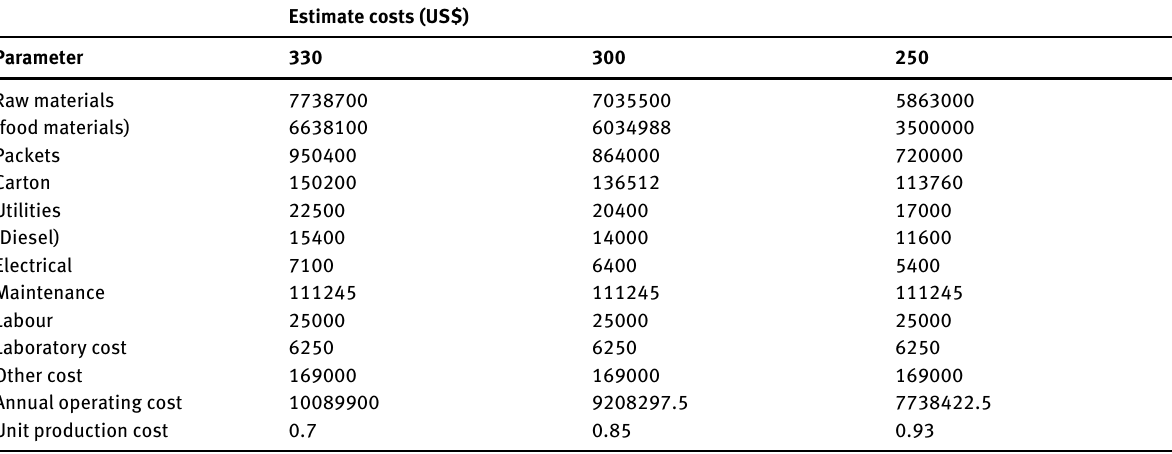
Table 3 : Annual production cost of the cookies production plant Estimate costs